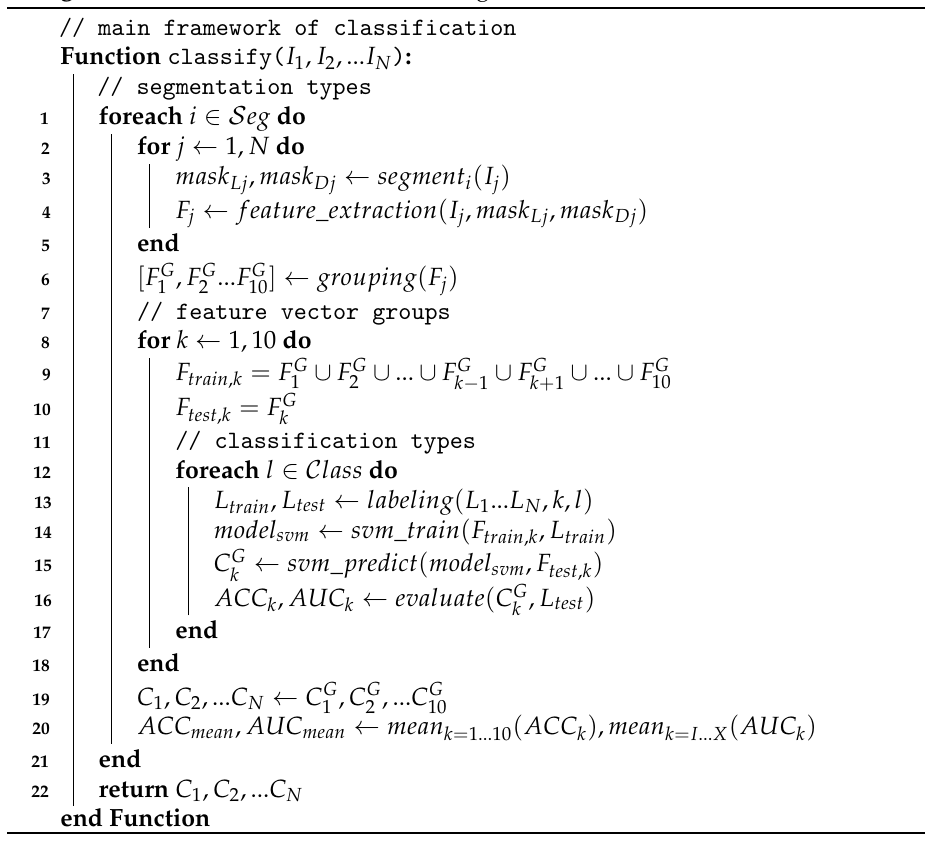
Algorithm 2: Skin lesion classification algorithm—Part II.